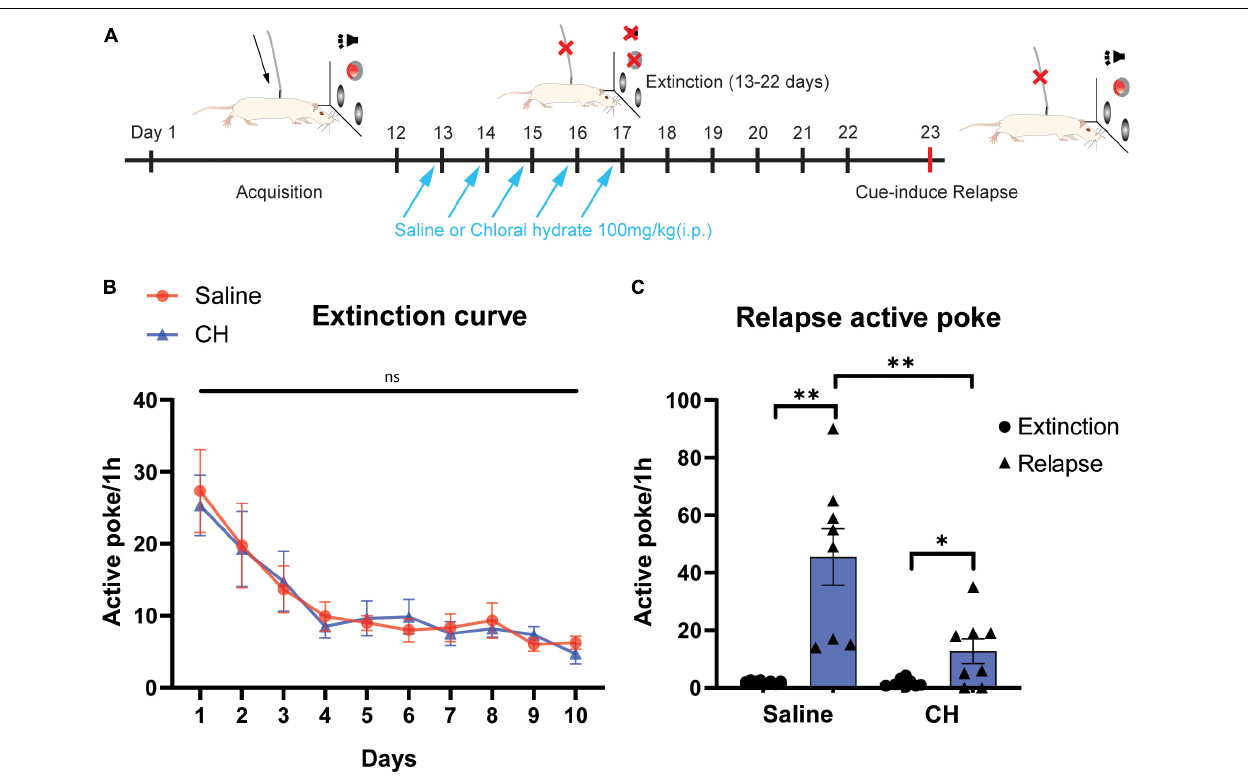
FIGURE 3 | Chloral hydrate reduced cue-induced relapse without affecting extinction in Meth self-administration model (A) Representation of extinction and relapse schedule. (B) Chloral hydrate treatment ( N = 12) has no effect on drug extinction, compared with saline control ( N = 12). (C) Chloral hydrate treatment ( N = 8) prevents cue-induced Meth relapse ( N = 8 for CH group and N = 8 for saline group). ∗ p < 0.05, ∗∗ p < 0.01, ns: no significant difference, Student’s t